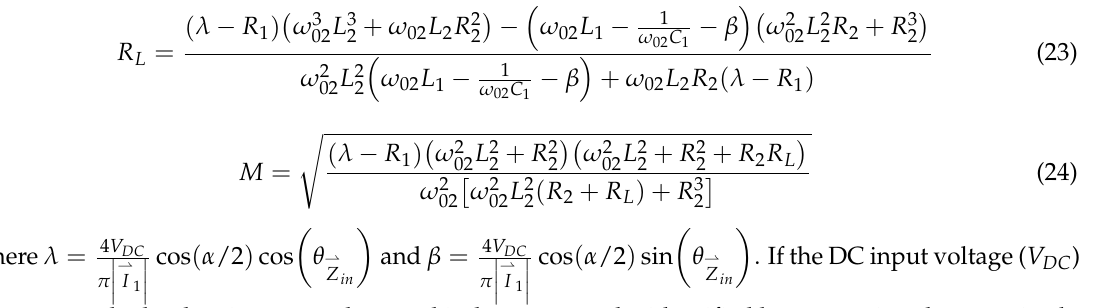
Figure 5. Gate signals and the corresponding waveform of the full-bridge inverter with phase-shift control. From (19) and (20), the identification of load resistance and mutual inductance can be realized